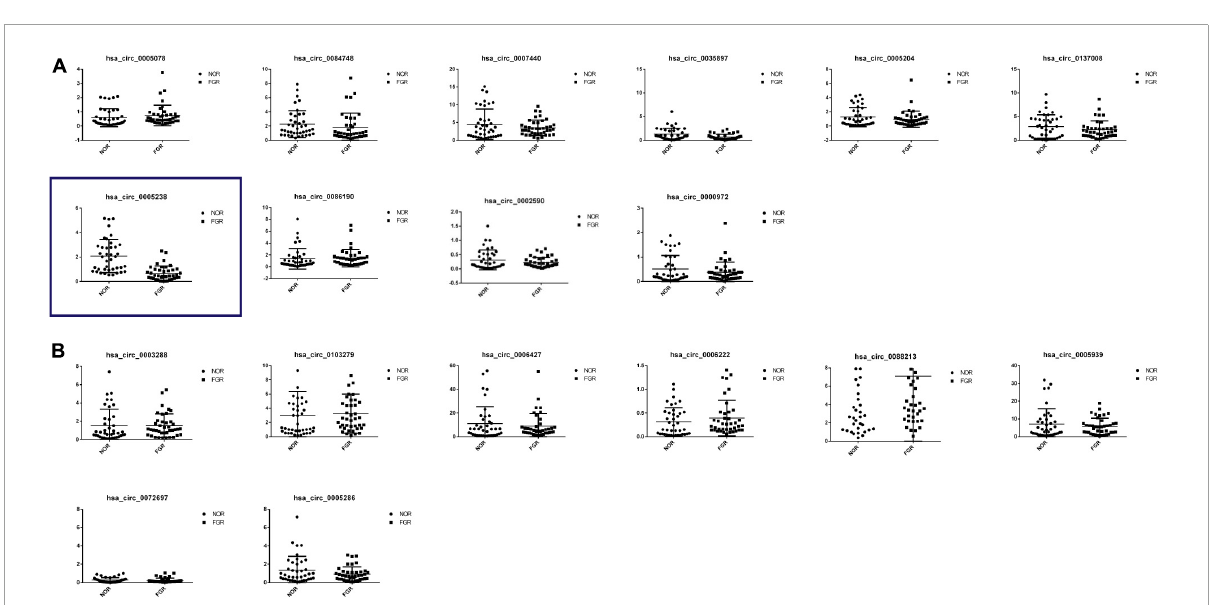
FIGURE3 Reverse transcription quantitative PCR (qRT-PCR) confirmation of 18 differentially expressed circRNAs. (A) Expression profiles of 10 down-regulated differentially expressed circRNAs by RT-PCR were consistent with the NGS results. Hsa-circ-0005238 was displayed in the blue box, which was significantly downregulation in FGR group. (B) Expression profiles of nine up-rerulated differentially expressed circRNAs by RT-PCR were consistent with the NGS